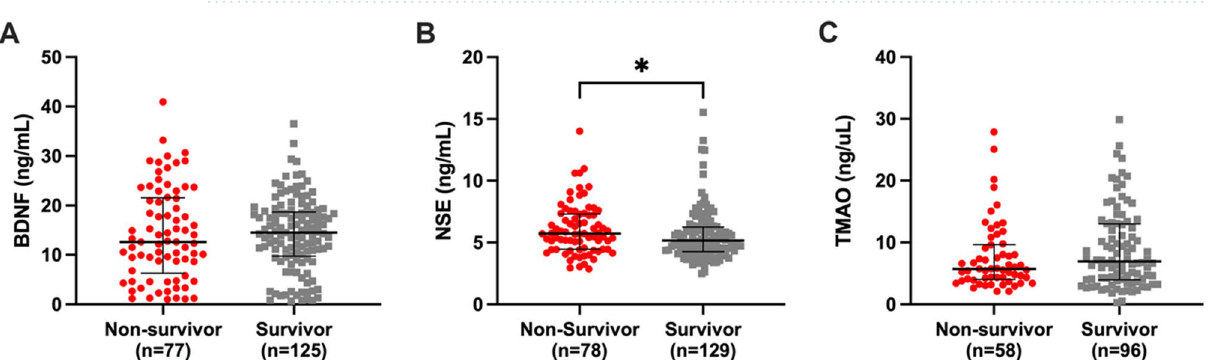
Figure 4. Mortality and serum concentration of biomarker in haemodialysis patients; ( A ) brain-derived neurotrophic factor (BDNF), ( B ) neuron-specific enolase (NSE), and ( C ) trimethylamine N-oxide (TMAO). The number of samples (n) that each analyte was detected in is noted for each group. Data presented at median and interquartile range when appropriate. Statistical significance, * p < 0.05, ** p <